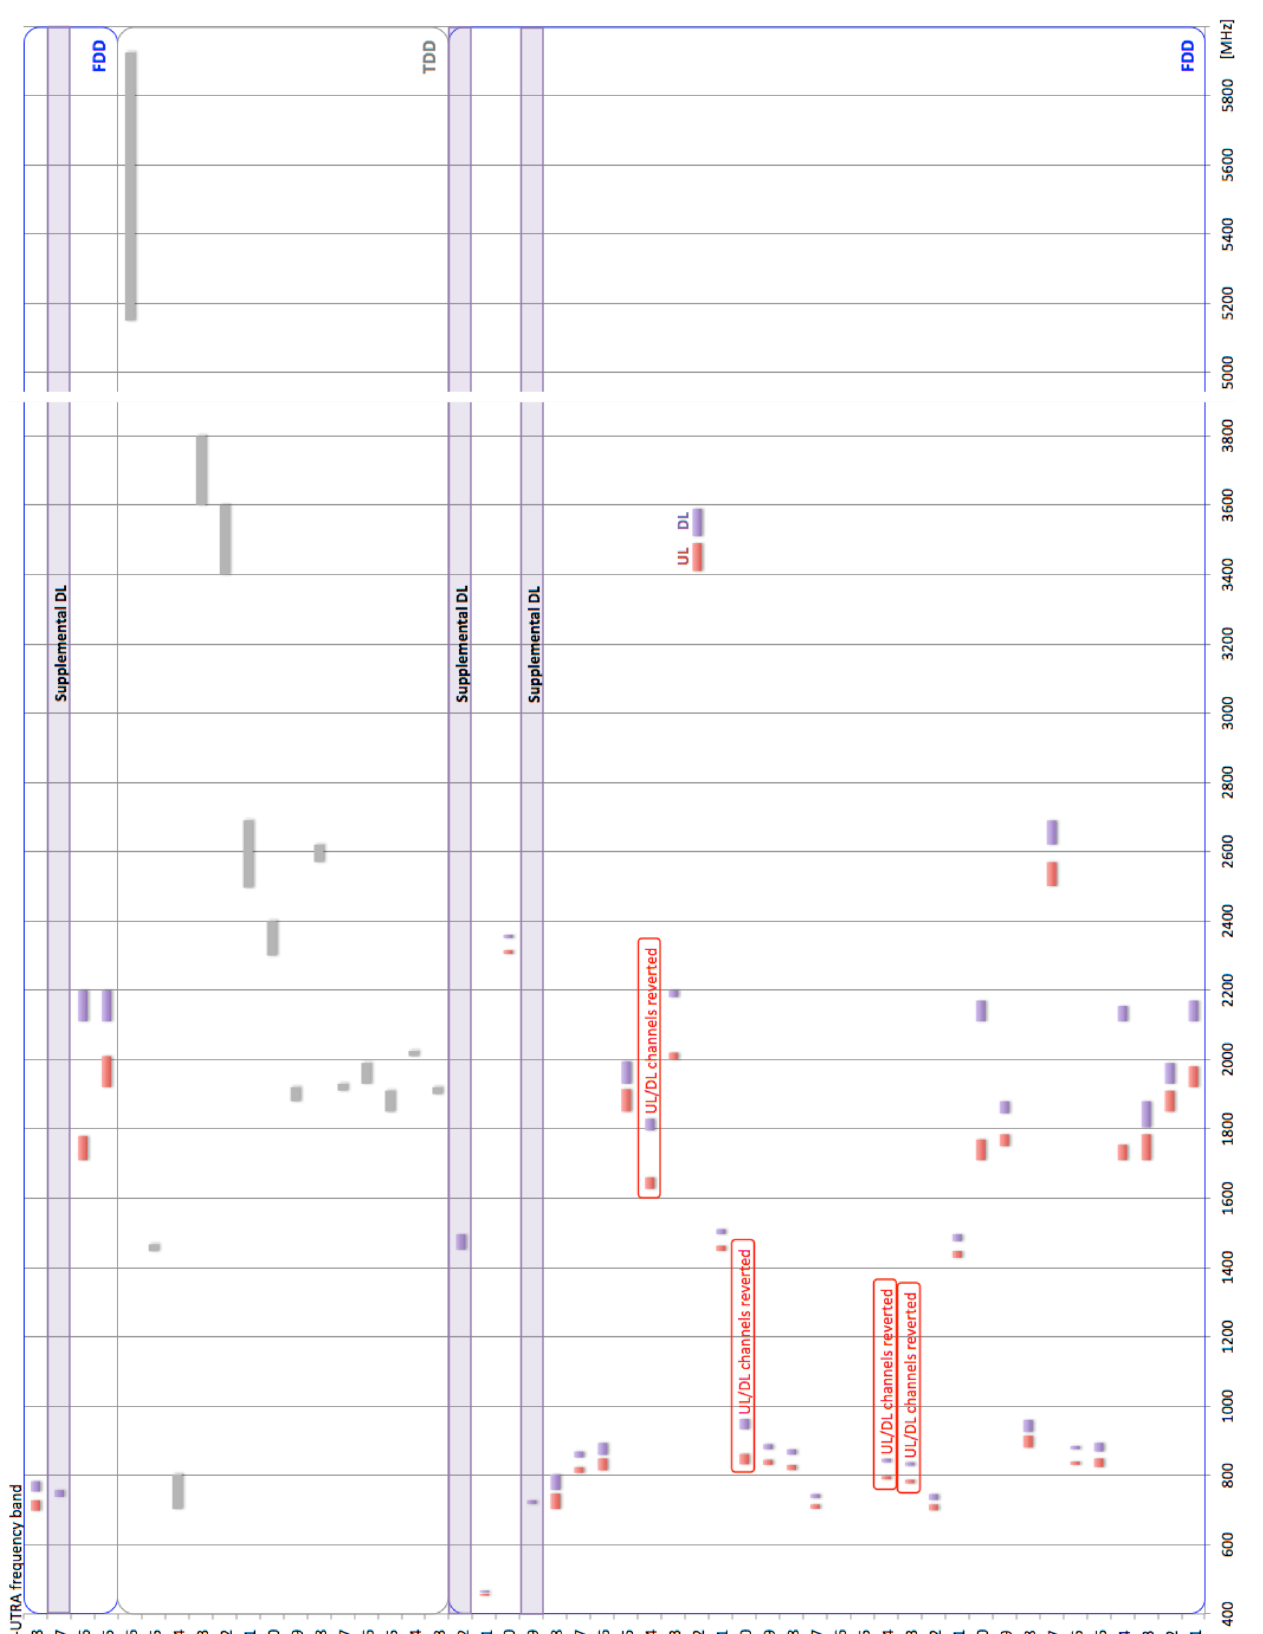
Figure 2 . E-UTRA frequency bands allocation